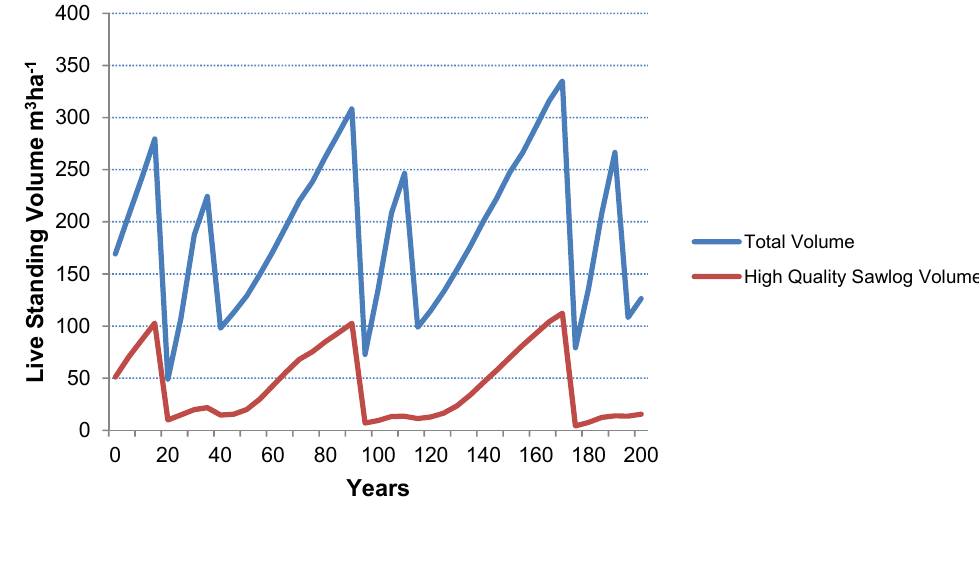
Figure 5. Total standing volume and high quality sawlog volume (m 3 ha − 1 ) for forests in Coopernook